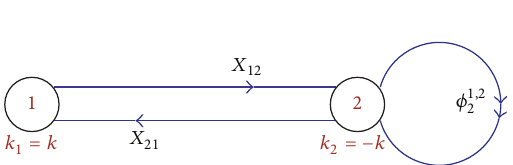
Figure 1: Quiver diagram (a).